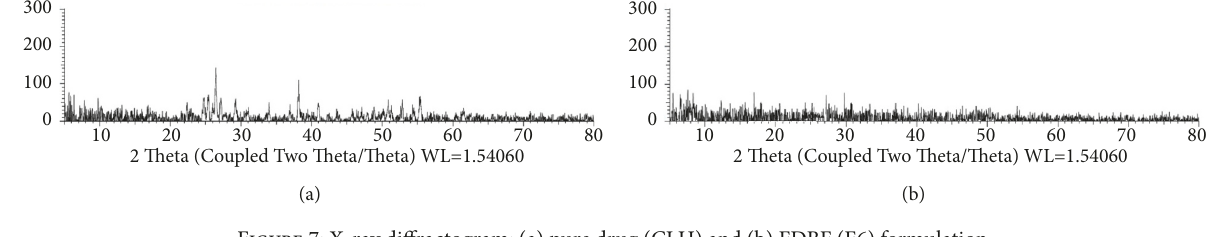
Figure 7: X-ray diffractogram: (a) pure drug (CLH) and (b) FDBF (F6) formulation. Table 5: Data represents the stability testing parameters of optimized formulation (F6) at accelerated conditions.